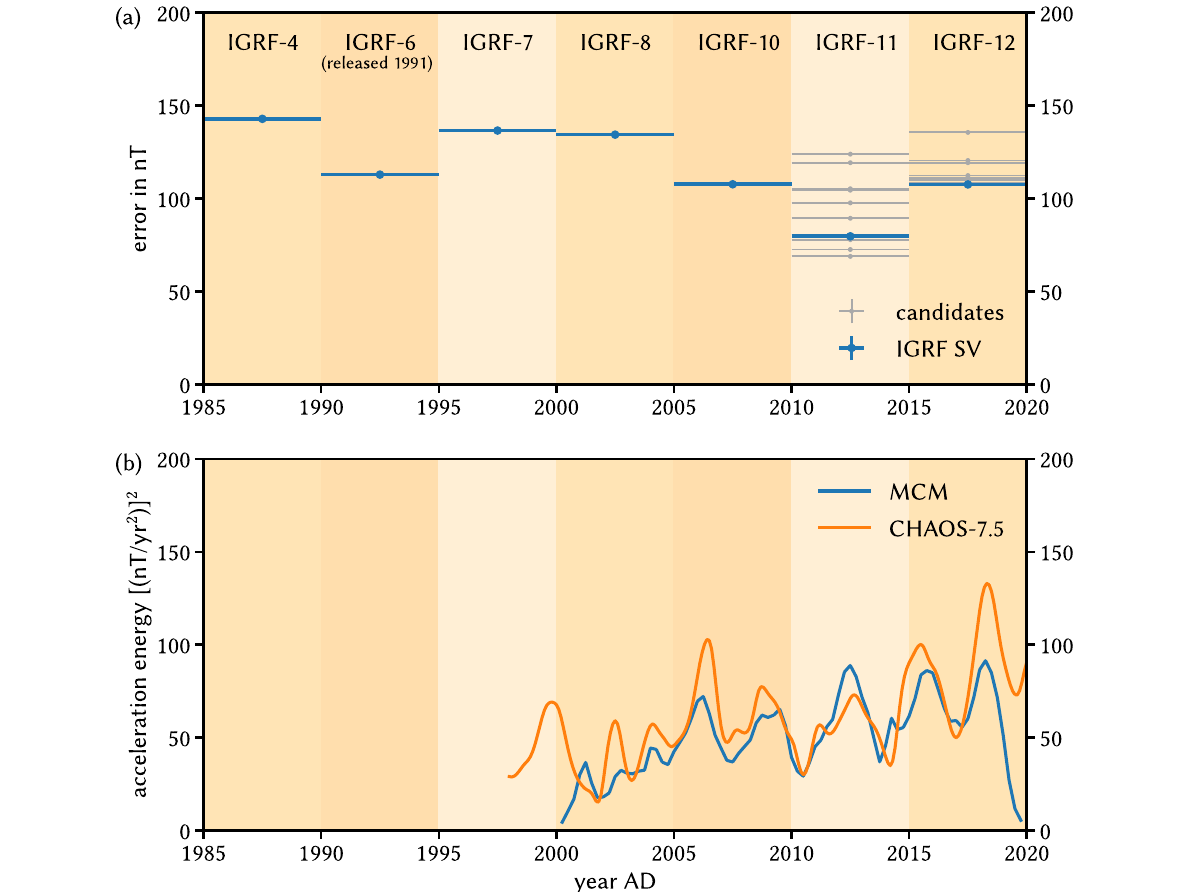
Fig. 2 a Intensity secular variation error (see text for its definition) for past generation IGRF SV models (in blue) and those SV candidates submitted for IGRF-11 and IGRF-12 (in grey), computed using fields expanded up to spherical harmonic degree and order 8. b Energy of the second derivative of the magnetic field, the secular acceleration, at Earth’s surface, up to spherical harmonic degree and order 8, according to the MCM model by Ropp et al. (2020) and the CHAOS model by Finlay et al. (2020), version